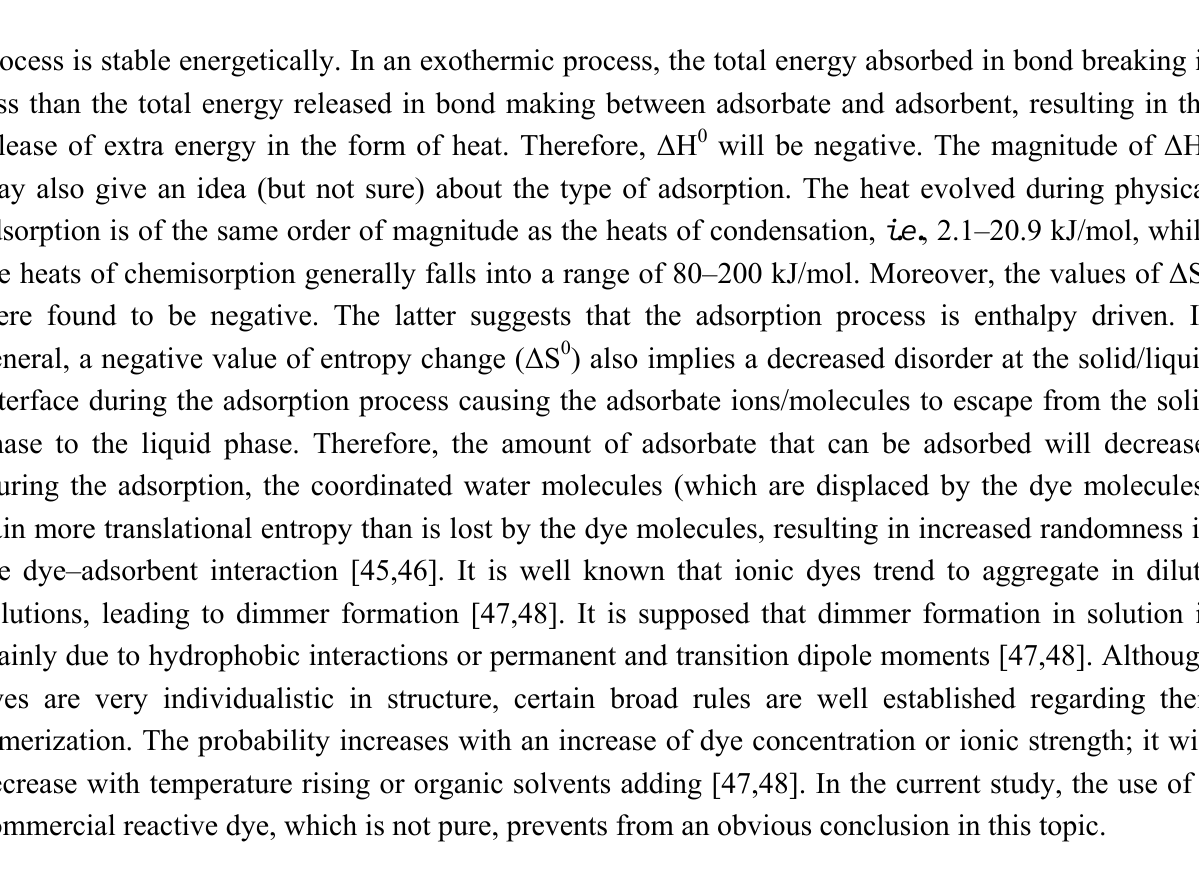
Table 3. Thermodynamic parameters for the adsorption of RB5 onto mGOi and mGOp.